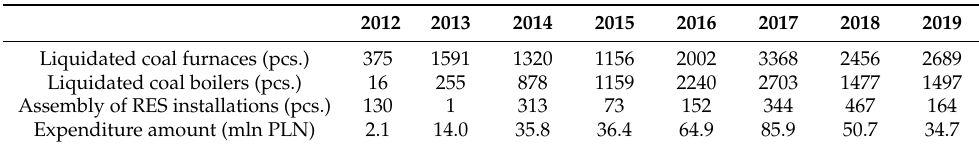
Table 1. The effects of the implementation of the Low-stack Emission Limitation Programme [52] for the city of Krakow 2012–2019 (based on the State of the City Reports 2012–2019 [48]). Pcs., number of installations. PLN, approximately EUR 0.24 (2012)–0.23